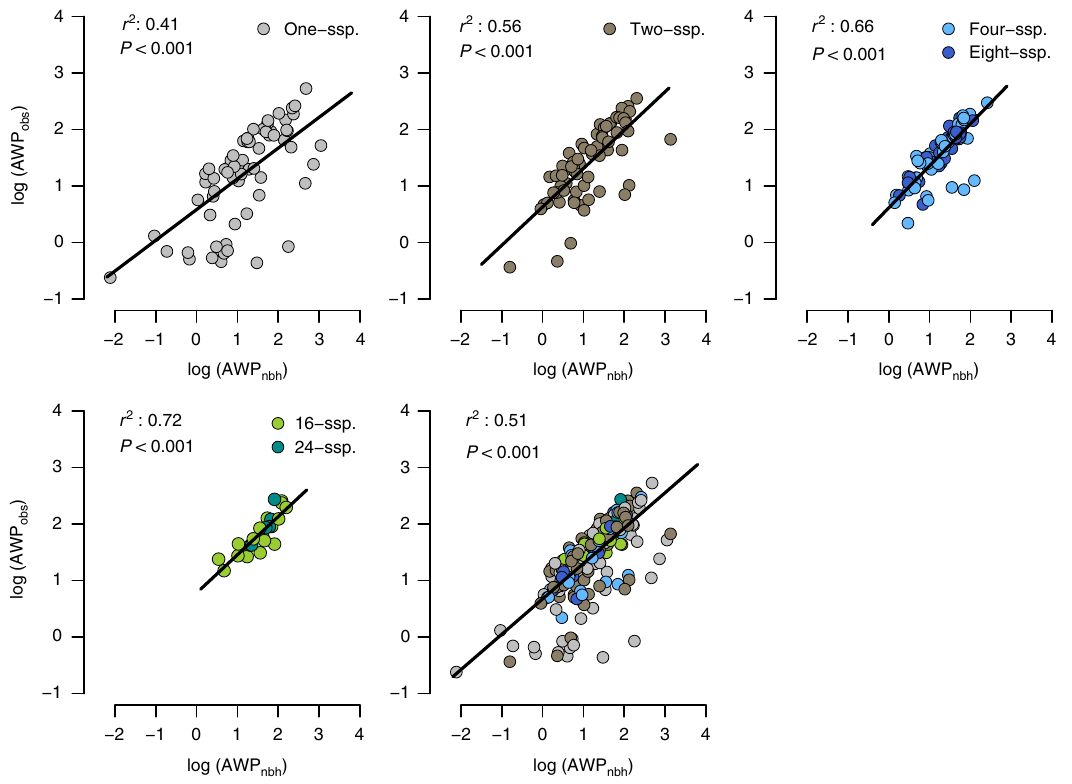
Fig. 3 Variation in the effects of neighbourhood interactions on community productivity between species mixtures. Standardised aboveground wood productivity (AWP, cm 3 cm − 3 year − 1 ) is based on observed (AWP obs ) and predicted (AWP nbh ) annual wood volume growth of all focal trees within a plot. Note that AWP nbh represents the net effect of aggregated neighbourhood interactions on community productivity as predicted by a neighbourhood model. Lines represent mixed-effects model fi ts for monocultures, species mixtures and across all monocultures and species mixtures: low (two-species mixture), medium (four- and eight-species mixtures) and high (16- and 24-species mixtures) level of community species richness (CSR). Marginal r 2 values ( fi xed effects only) are shown for each CSR